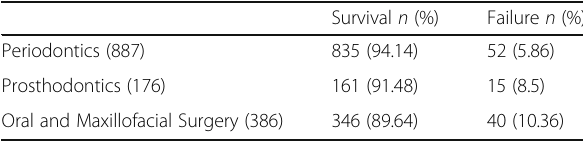
Table 4 Distribution of implant outcomes among various